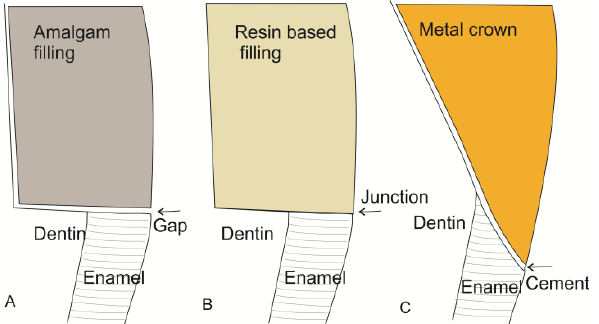
Figure 3. Different biomaterials create different types of junctions between tooth and restoration. The illustrations represent cross sections of the tooth-restoration border. ( A ) An amalgam filling is not directly attached to the tooth. The gap is a potential area for ingrowth of bacteria which causes secondary caries; ( B ) The resin based fillings are supposed to be adhesively attached to the tooth substance with no gaps in between. This requires that the filling is placed and cured with a special technique to avoid gaps caused by polymerization shrinkage; ( C ) A crown is fixed to the tooth by means of cement which fills the gap between tooth and restoration. This will always cause irregularities on the surface. The exposed cement is subjected to wash out and wear causing an increase of the groove over time.